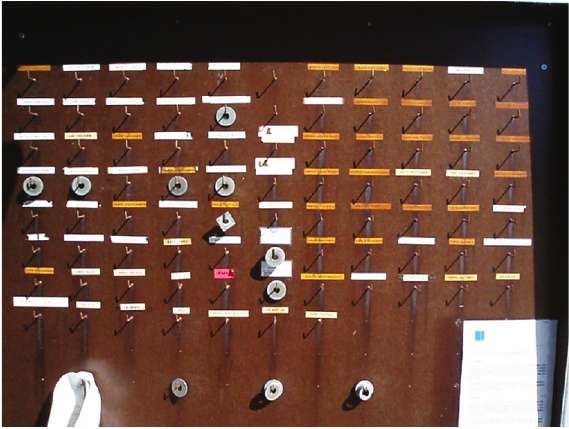
Figure 1: Washer board